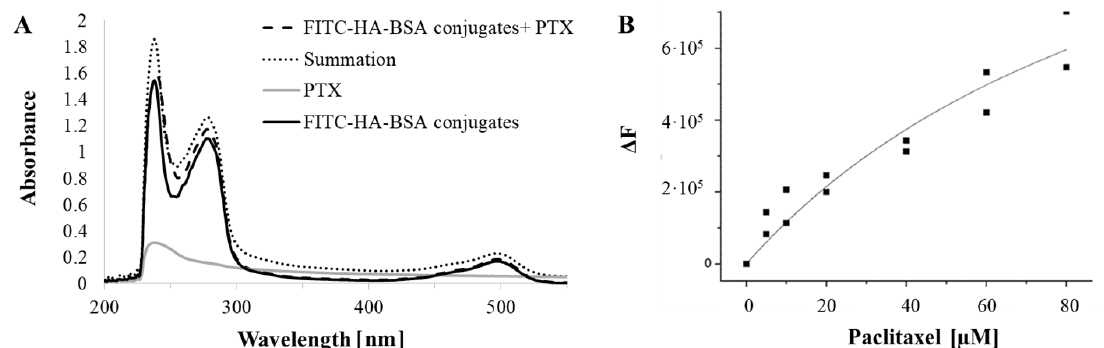
Figure 2. ( A ) Absorbance of FITC-HA-BSA conjugates (40 µM; black solid line); of (80 µM) PTX encapsulated in the conjugate NPs (dashed line), (PTX: FITC-HA-BSA conjugate molar ratio of 2:1), of pure PTX (80 µM, gray solid line) and the absorbance summation of FITC-HA-BSA conjugates and PTX (dotted line); ( B ) Fluorescence quenching of HA-BSA by PTX as a function of PTX concentration. The excitation and emission were at 290 and 350 nm, respectively. The curve is a fit to a Langmuir- based model as described in Equation (2).